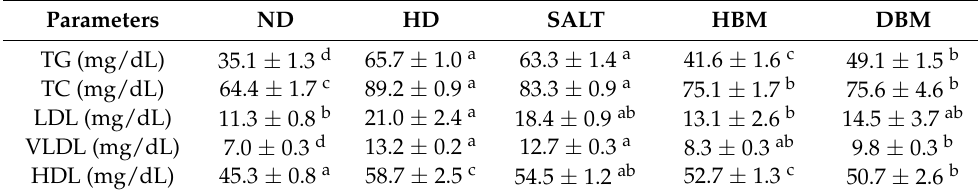
Table 2. Serum lipid levels.